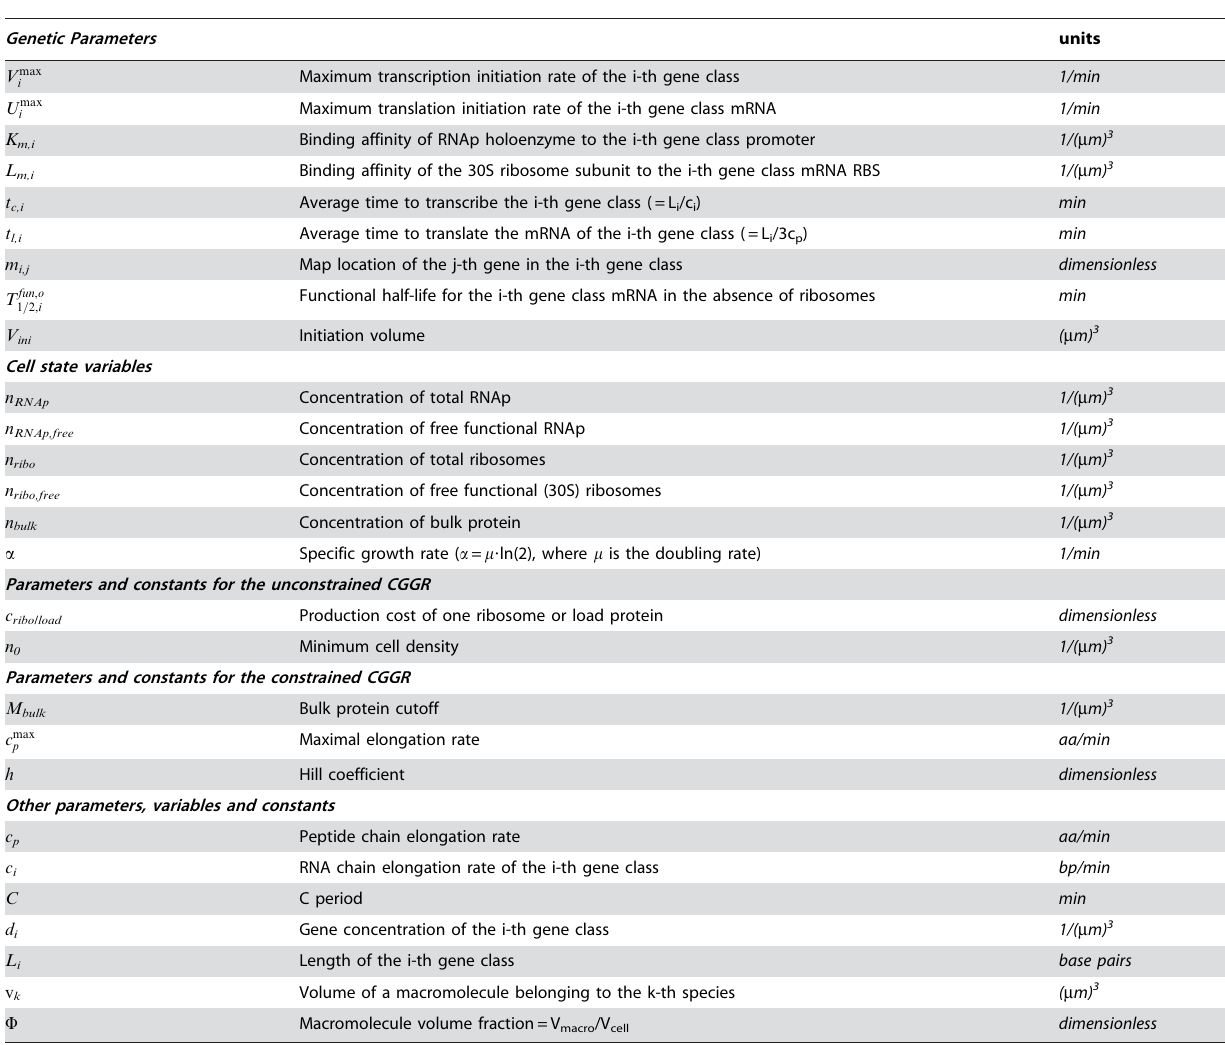
Table 2. CGGR variables, parameters and constants.